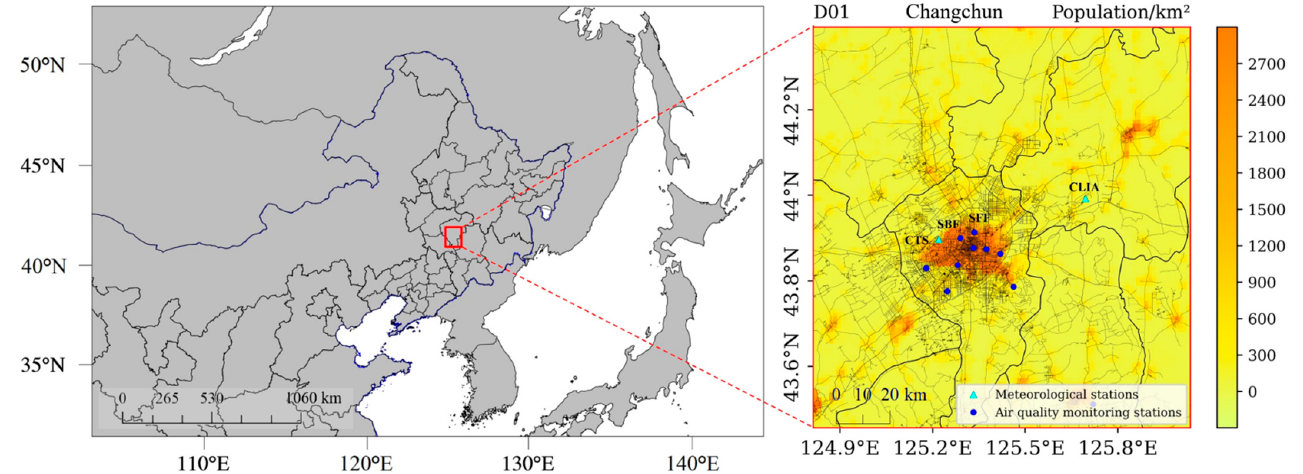
Figure 1. Model domain setting of WRF-VEIN-CHIMERE system and spatial distribution of population, road networks and observation sites in Changchun, Northeast China.